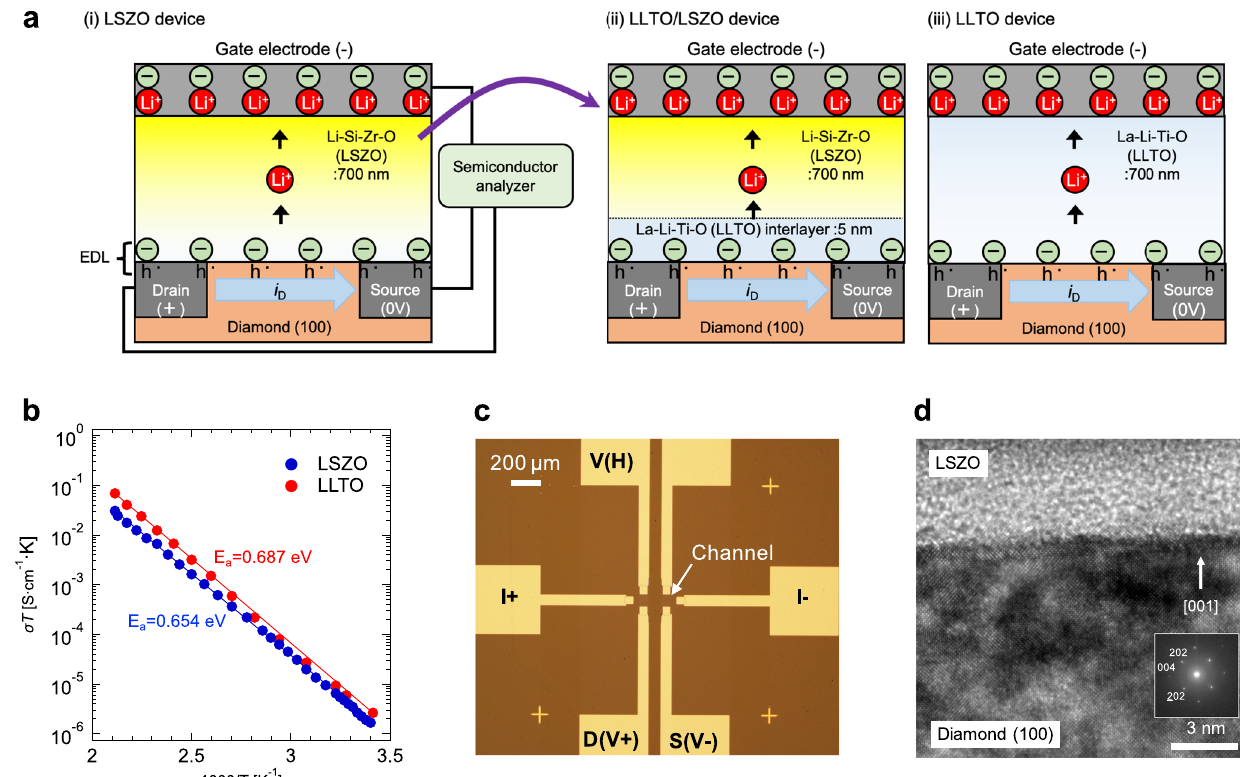
Fig. 1 H-diamond-based EDLTs consisting of Li + electrolyte thin fi lms. a Illustrations of three diamond-based EDLTs consisted of Li-Si-Zr-O (LSZO) or La-Li-Ti-O (LLTO) Li + solid electrolyte thin fi lms [(i)LSZO device, (ii)LLTO/LZSO device, (iii)LLTO device]. Li + in the electrolytes is depicted only for indicating polarity of electric current. b Arrhenius type plots of the ionic conductivities of LSZO and LLTO fi lms. c Optical image of a hall-bar shaped hydrogen-terminated channel. d High resolution transmission electron microscope (HR-TEM) image of the LSZO/H-diamond